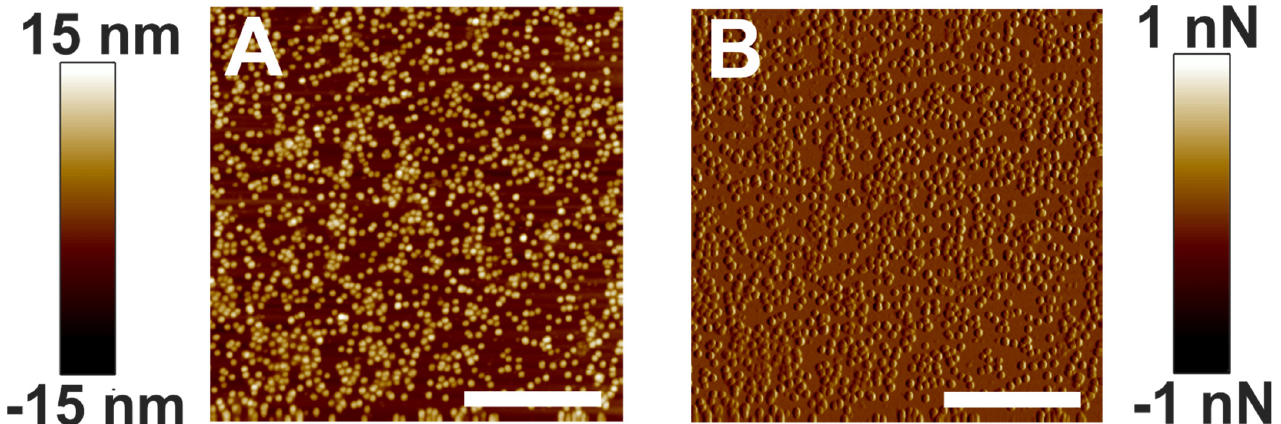
Figure 5. α -Crystallin adsorbed in mica. ( A ) Height image of the α -crystallin oligomers adsorbed in the mica disk. ( B ) Corresponding peak force error image. Image scale: 1 µm.